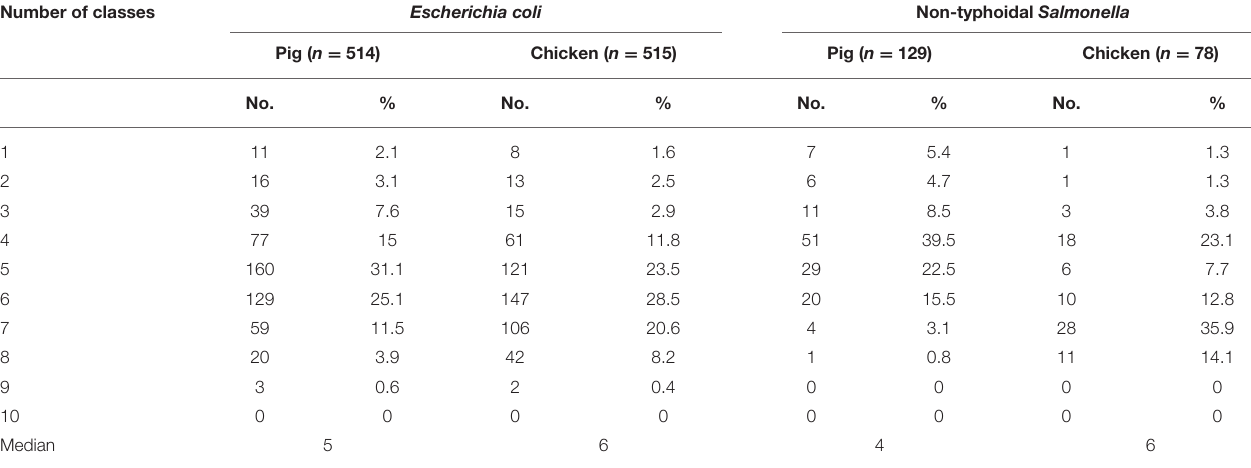
TABLE 4 | Distribution of multidrug resistant isolates collected from pig and chicken samples during three rounds of antimicrobial resistance surveillance in five provinces in Vietnam, 2017–2019. Number of